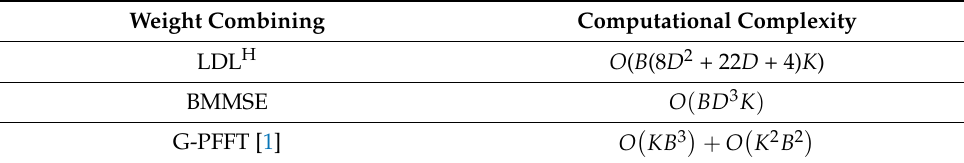
Table 2. Complexity analysis of different weight combining